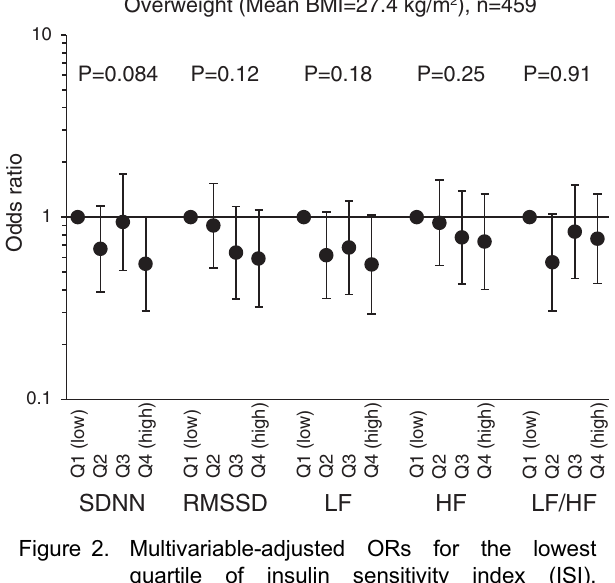
Figure 2. Multivariable-adjusted ORs for the lowest quartile of insulin sensitivity index (ISI), grouped according to quartiles of heart rate variability parameters in both overweight and non-overweight subjects. The ORs were adjusted for sex, age, BMI, use of antihypertensive agents, DBP, physical activity, smoking habit, and alcohol consumption. P values present the linear trends using continuous variables for each parameter in the